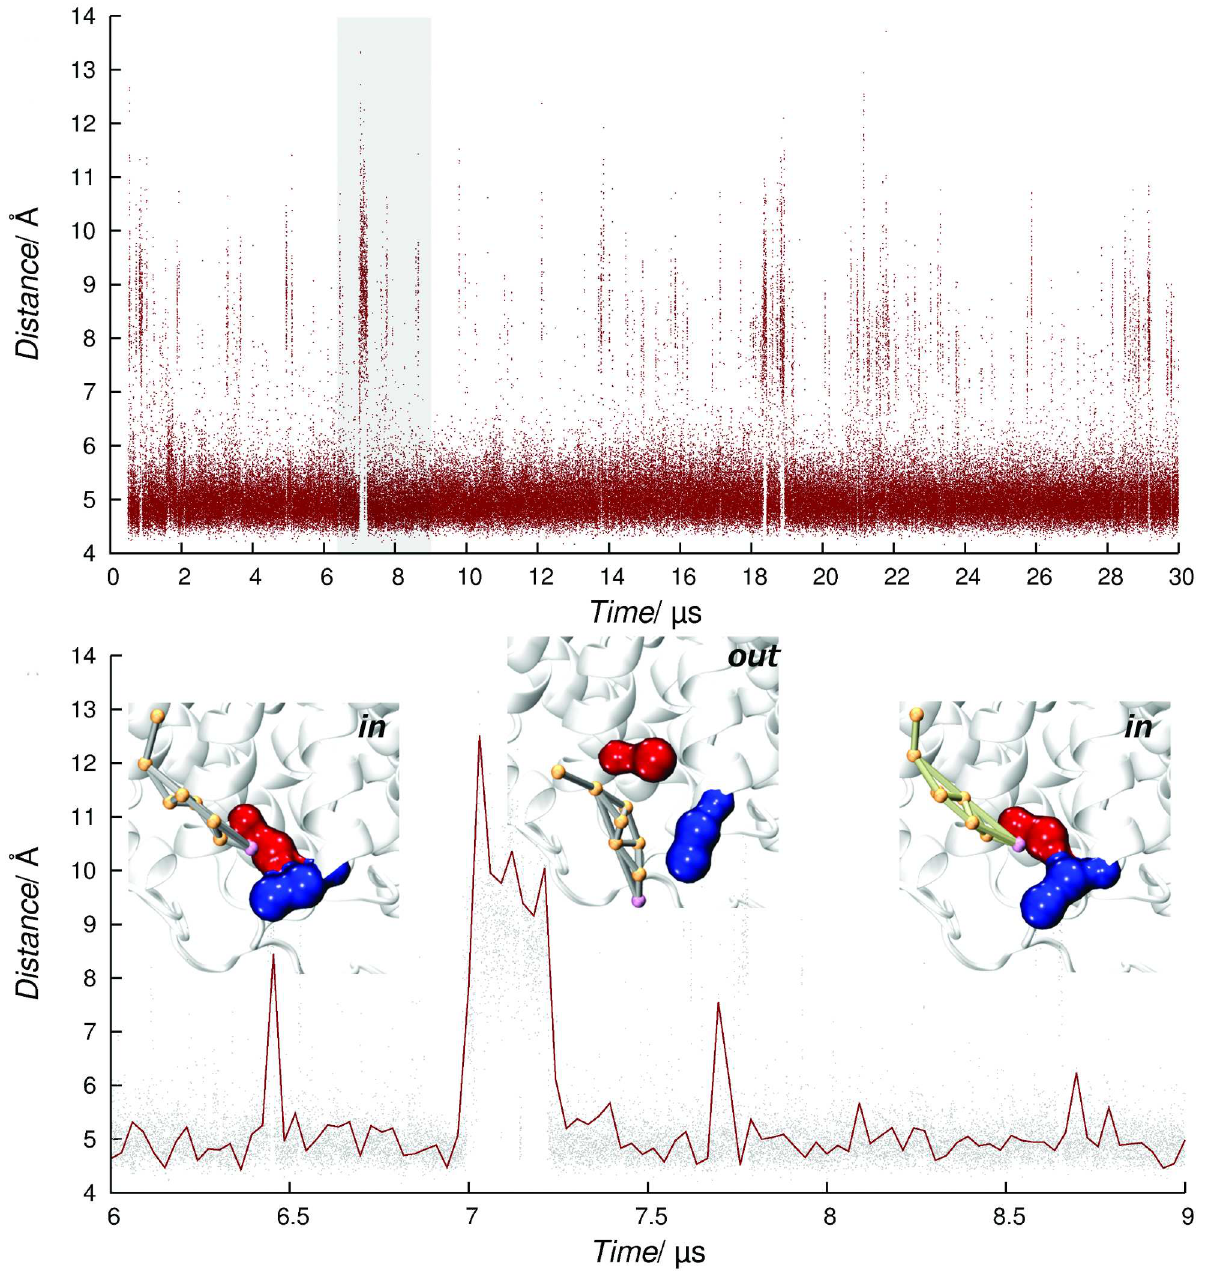
Fig 6. Distance between K85-D360 side chains taken from a representative trajectoryof SYS3. The three insets show the two residues as blue and red surfaces in contact with cholesterol molecules(grey and green) in the time interval definedby the gray